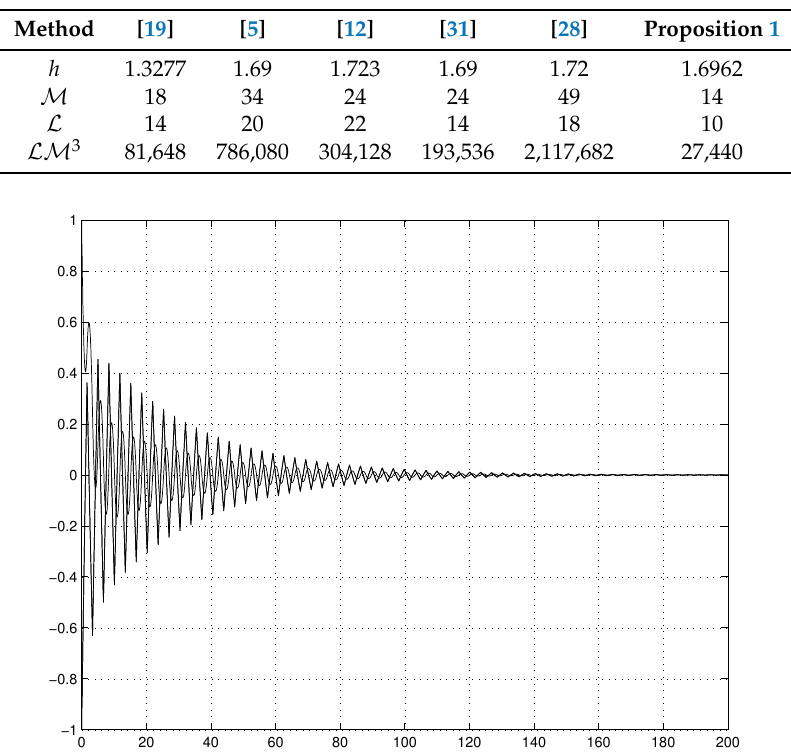
Table 2. h , M and L of LMIs.